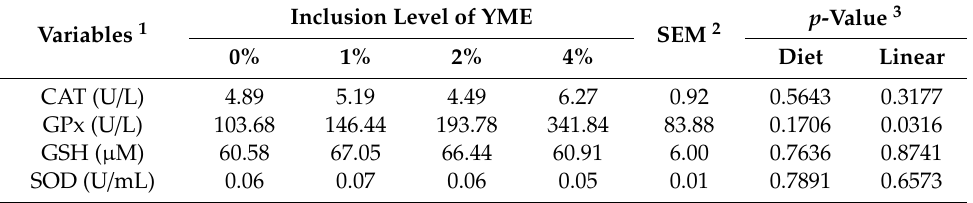
Table 3. E ff ect of yerba mate extract (YME) supplementation on the antioxidant status of lambs. Inclusion Level of YME Variables 1